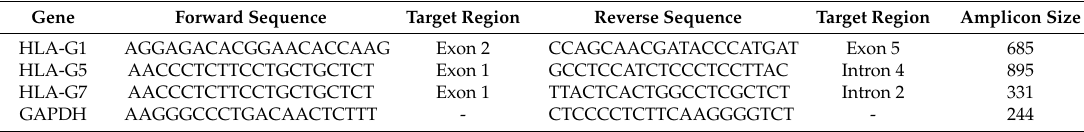
Table 1. Primer Set used in